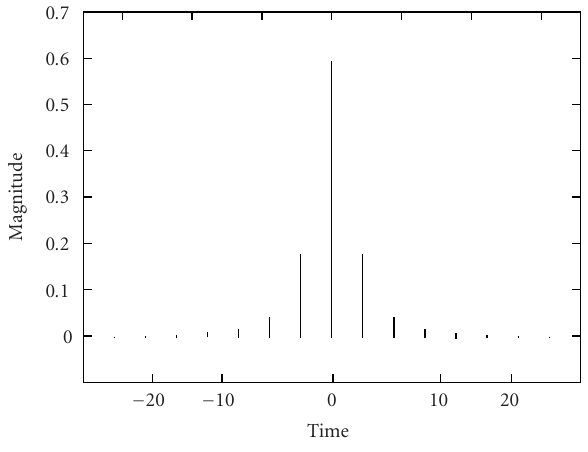
Figure 4.6. Samples of sinc-square function. Table 4.1. Uncertainty product for various signals of unit